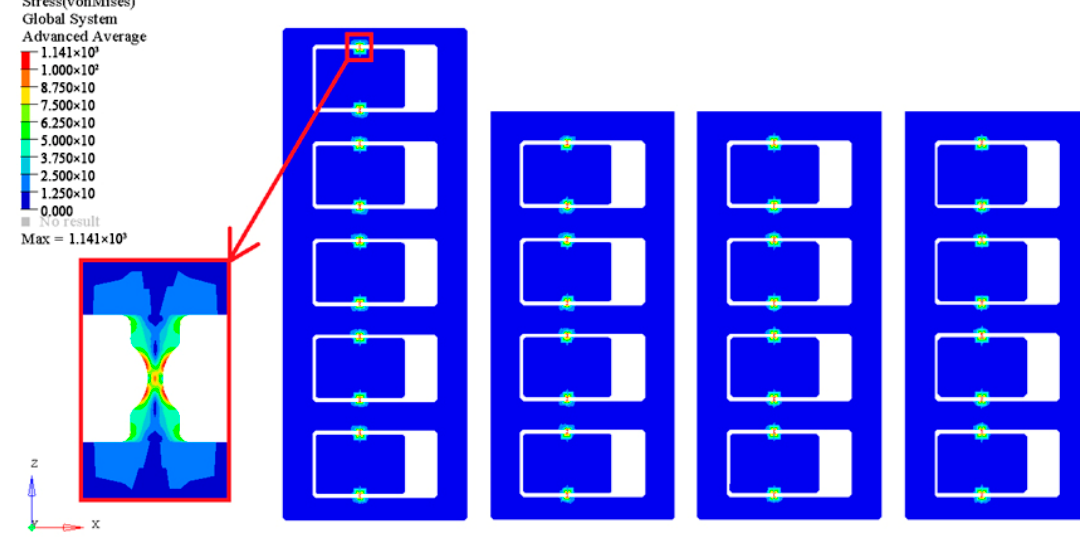
Figure 2. Stress of the centrifugal overload of the MEMS S&A device.